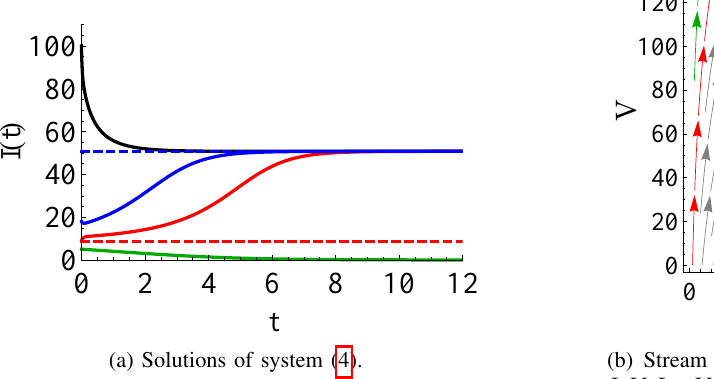
I, V, I + V ≤ K . Fig. 1: Solutions of system (4) in case there is a backward bifurcation at R 0 = 1 and R c < R 0 < 1 . We let Λ( x ) = x and choose parameter values as µ = 0 . 1 , γ = 12 , θ = 0 . 5 , σ = 0 . 2 , φ = 16 , c = 1 , d = 1 . 8 , c + dx β = 0 . 33 , η = 5 , ω = 5 , which makes K = 153 . 6 and R = 0 . 95 . Endemic equilibria (˘ I , ˘ V ) = (8 . 6 , 135 . 4) 0 1 1 and (˘ I 2 , ˘ V 2 ) = (50 . 7 , 82 . 8) are represented as (a) red-dashed and blue-dashed lines, (b) red and blue points, respectively. On (b) the green point denotes the unique disease-free equilibrium (0 , 148 . 4) . Solutions with initial values ( I (0) , V (0)) = (9 , 120) – red curve, (18 , 130) – blue curve and (100 , 50) – black curve converge to (˘ I 2 , ˘ V 2 )